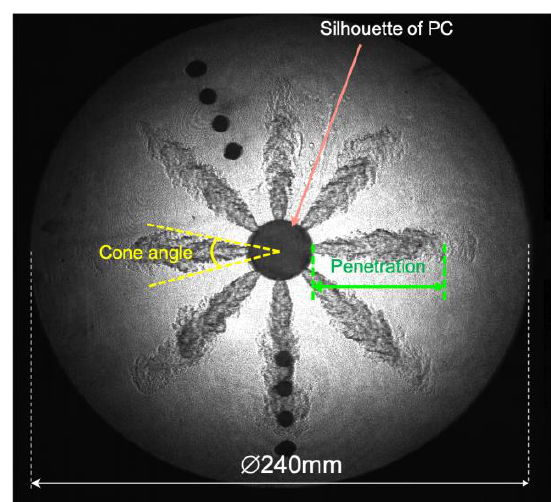
Fig. 6. Example of torch flame observation in the main-chamber Figure 7 shows the time history of penetration and cone angle of the torch flames under the three different ambient gas conditions, and Fig. 8 shows the shadowgraph images of the torch flames corresponding to the above conditions. The elapsing time in Fig. 7 starts when the torch flames begin ejecting from the orifices of the PC. The experiments were conducted five times for all the conditions, and the penetration and the cone angle of the torch flame are ob- tained as the averages of the torch flames from all orifices, and furthermore, they are averaged over the five runs.